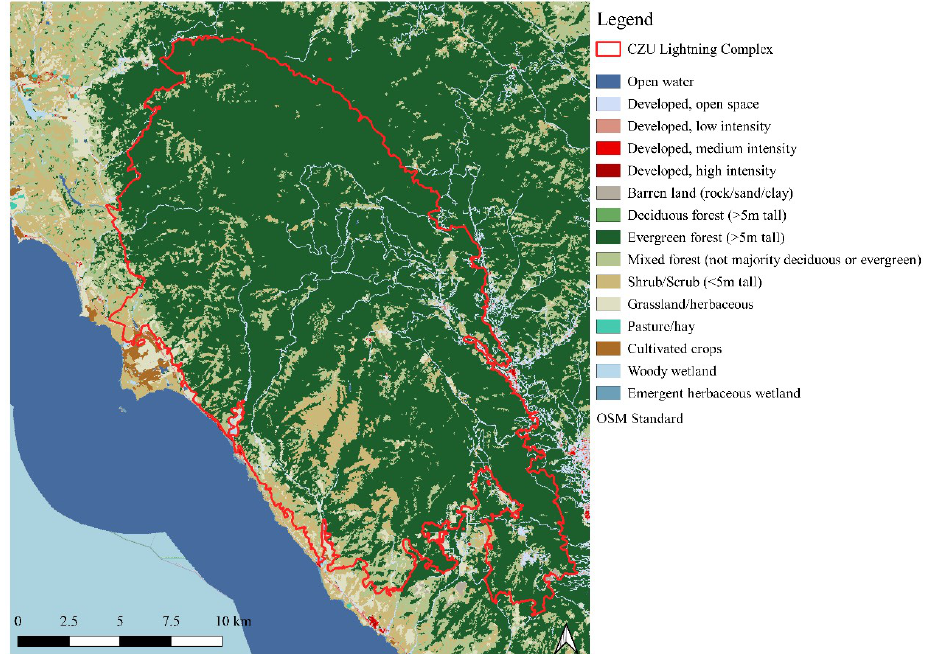
Figure 10. Land cover classifications inside the CAL FIRE perimeter of the CZU Lightning Com- plex.